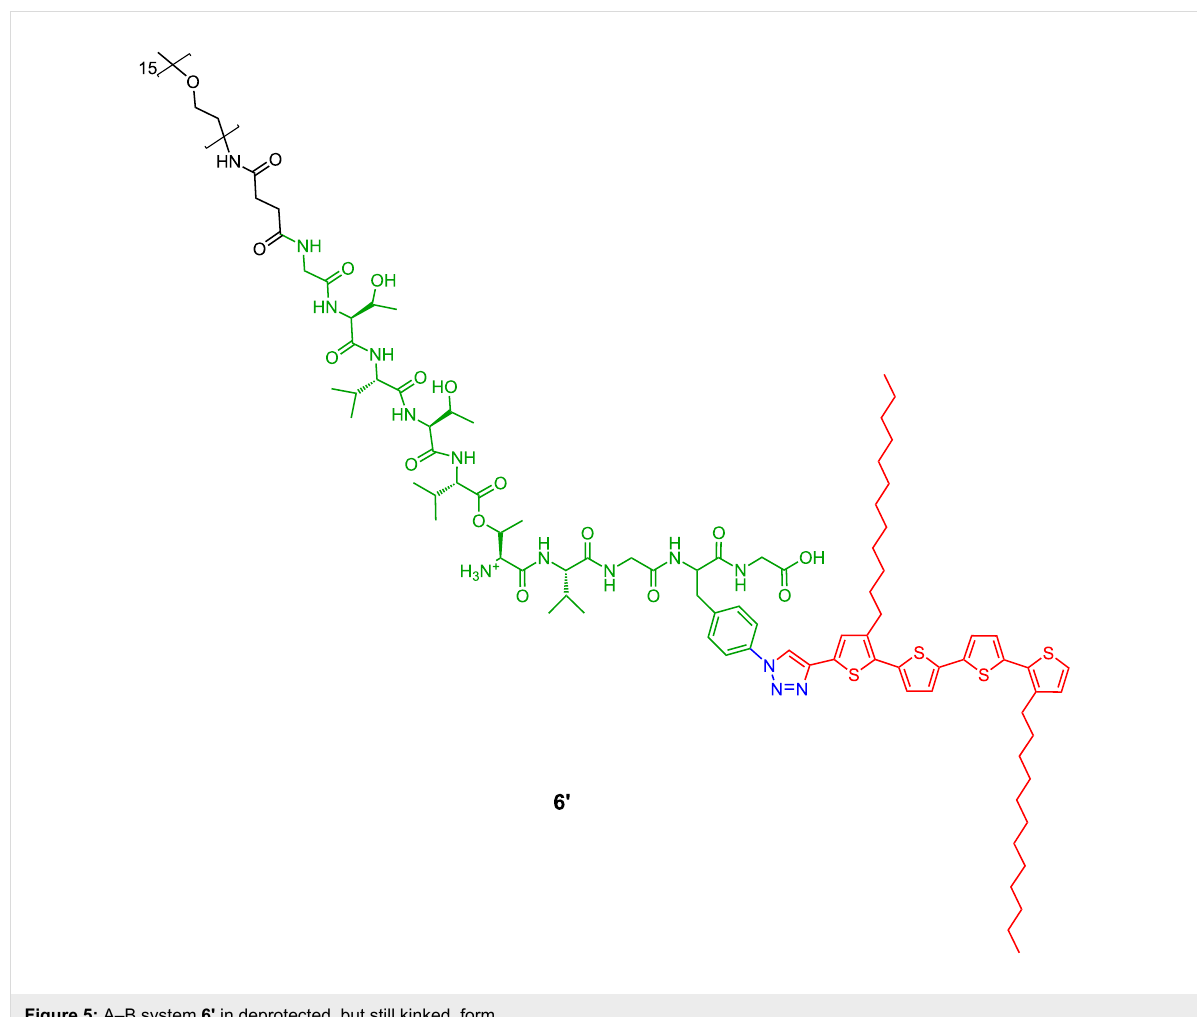
groups present in hybrid 6 are removed, except for the switch ester segment, which is preserved. Thus, the molecule 6' still exhibits a kink in the peptide backbone (Figure